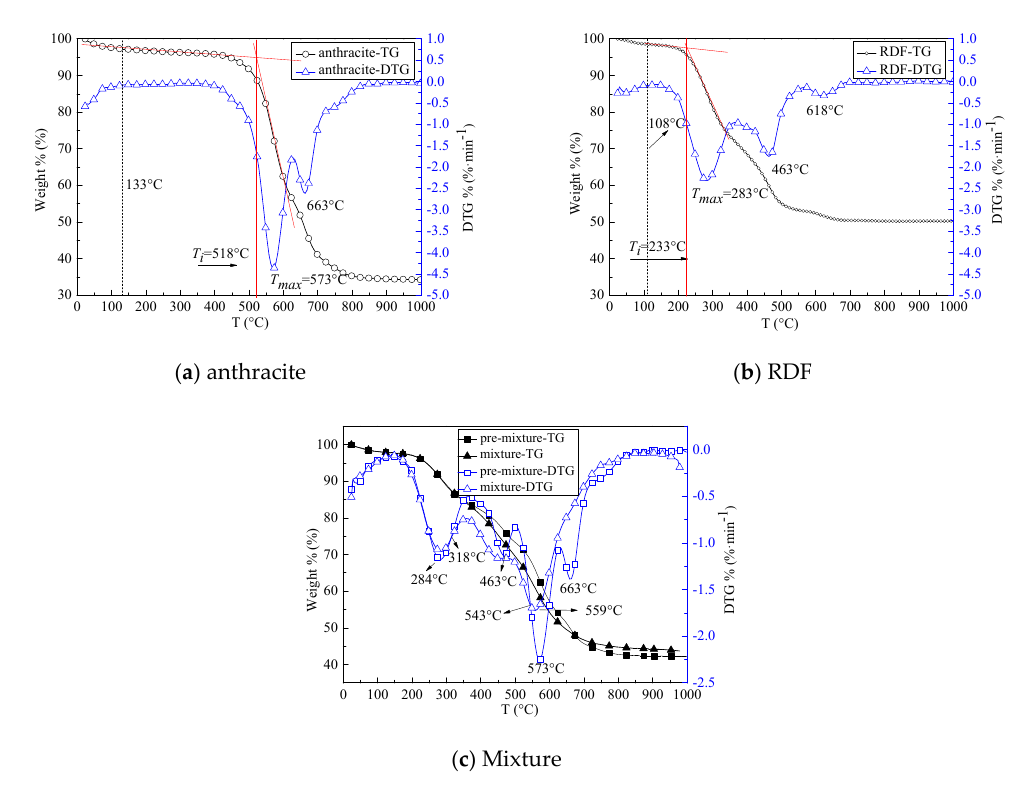
Figure 2. TG-DTG profiles of fuels combustion. Table 2. Combustion characteristic parameters of samples.